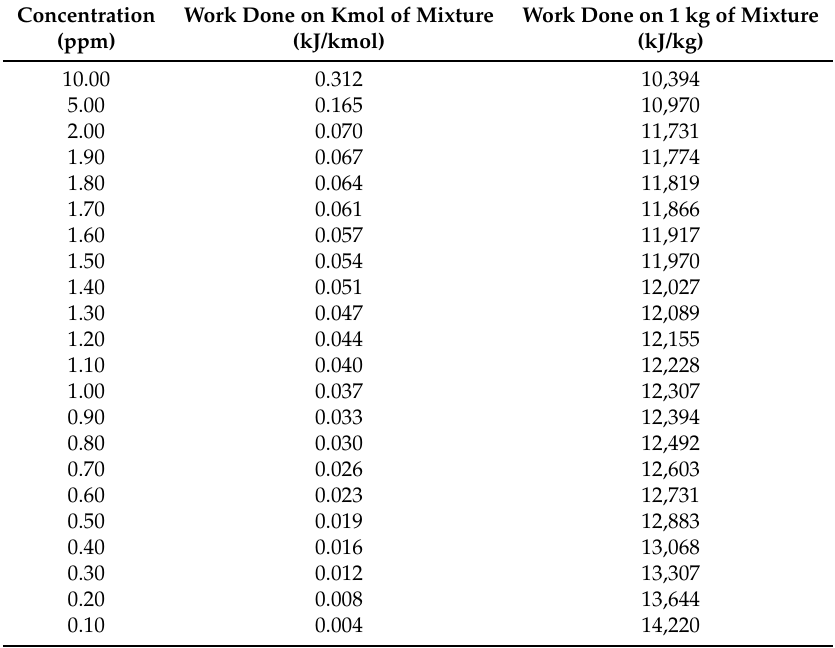
Table 7. Minimal work for